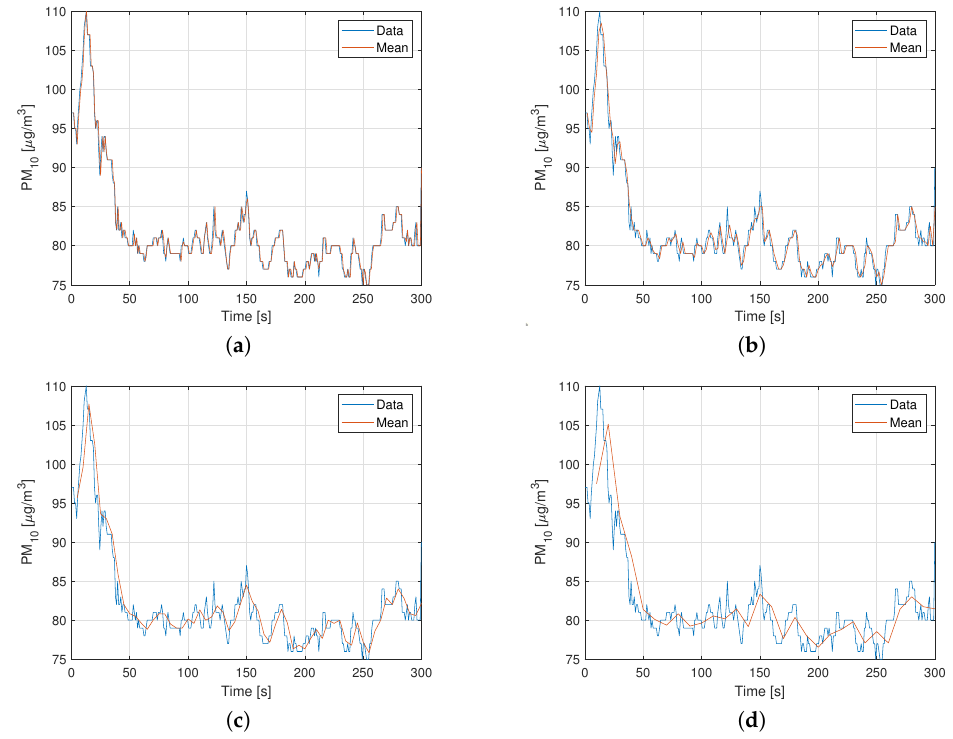
Figure 7. Raw data and average of PM 10 data from the single sensor for selected averaging periods: ( a ) 1 s; ( b ) 2 s; ( c ) 5 s; ( d ) 10